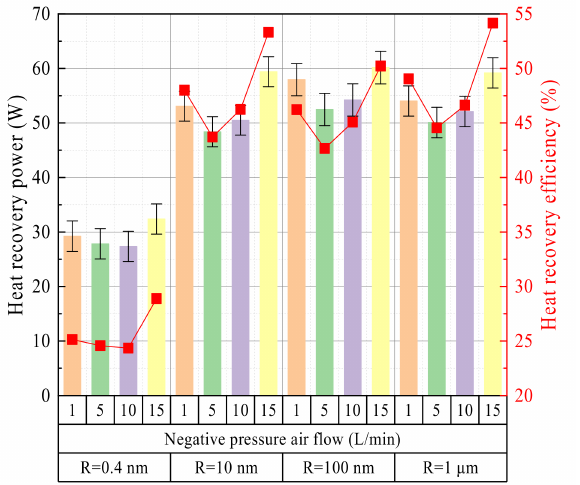
Figure 16. Heat recovery power/efficiency vs. negative pressure airflow. Experiment conditions: flue gas flow 10.58 L/min, flue gas inlet temperature 56.31 ◦ C, negative pressure air inlet temperature 12.68 ◦